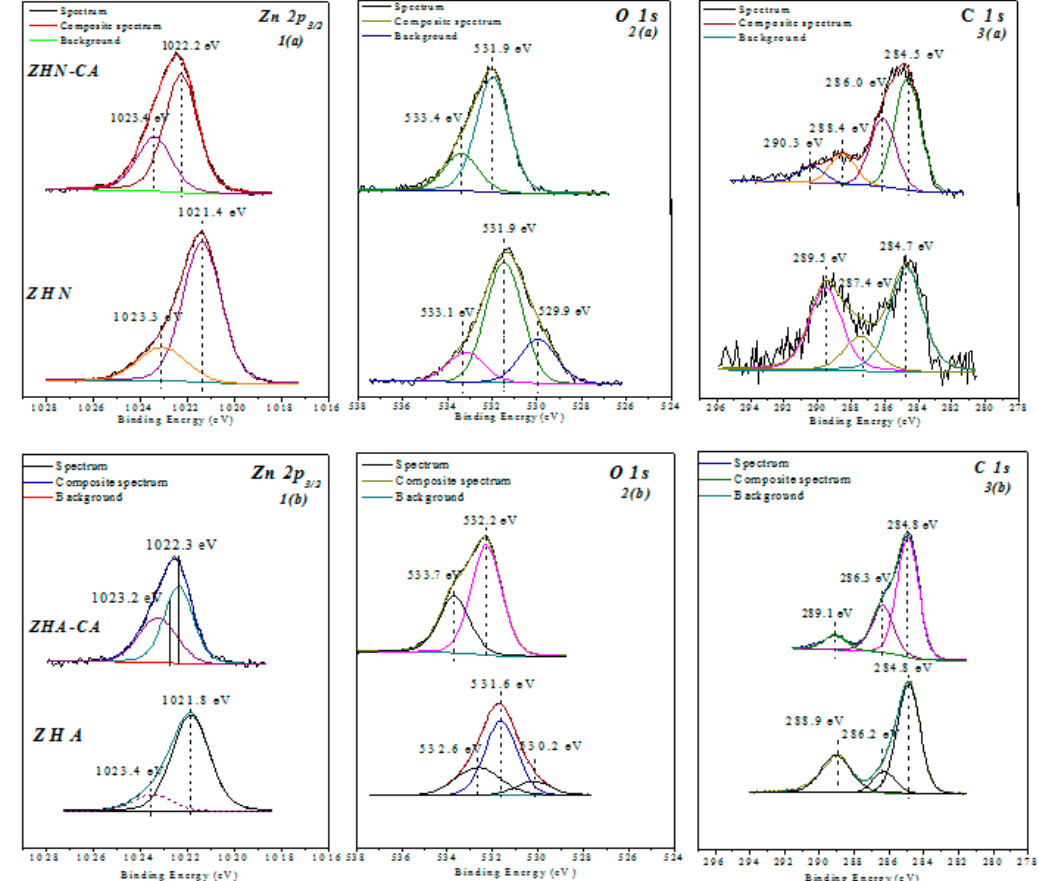
Figure 7. High-resolution XPS of chemical state ( 1 ) Zn 2 p 3/2 , ( 2 ) O 1 s , and ( 3 ) C 1 s for ( a ) ZHN and ZHN–CA, and ( b ) ZHA and